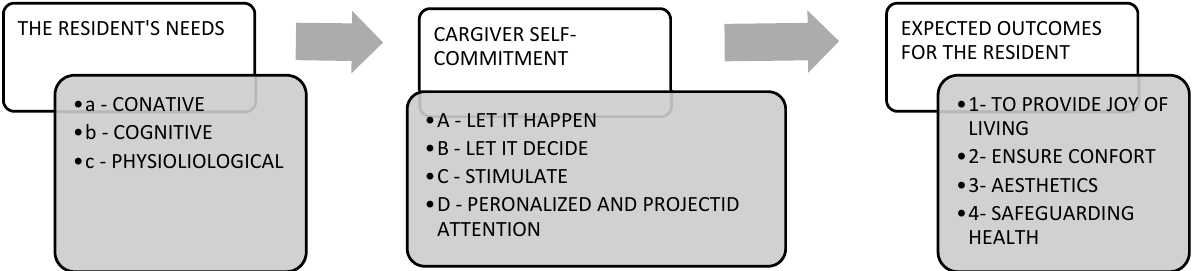
Figure 3. Concept map of health caregiver’s engagement and self-realization.